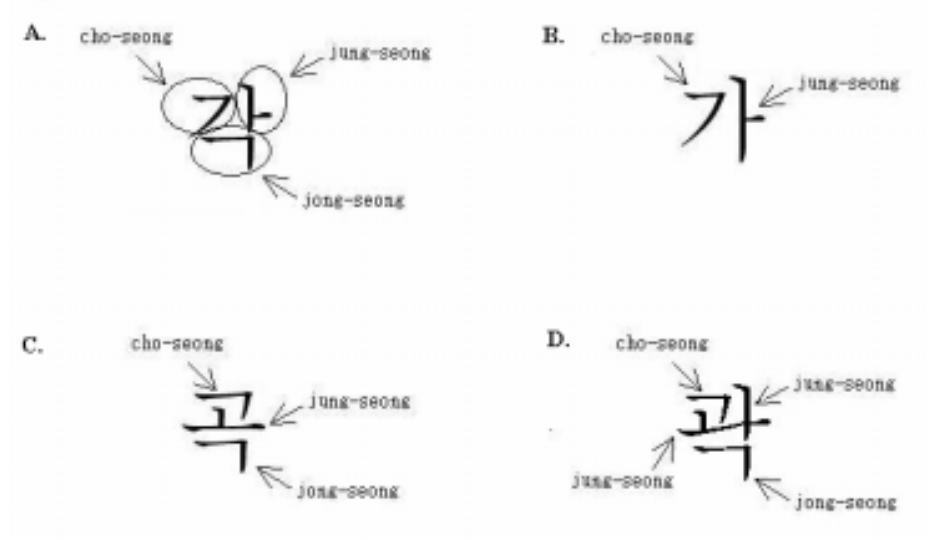
Fig. 1. The writing system of a Korean syllable. A : initial ( ), medial ( ), and final ( ), graphemes are named as cho-seong, jung-seong and jong-seong, respectively. jung-seong ( ) is written right of cho-seong ( ); B : Notice that this syllable does not contain a jong-seong, but still remains as a syllable, demonstrating jong-seong can be an optional element of a syllable; C : Notice that the shape of cho-seong is altered ( → ) on this syllable as a consequence of the locus change of jung-seong from the right ( ) to the bottom ( ) of cho-seong; and D : This syllabic block has two jung-seong graphemes written wrapping around cho-seong.